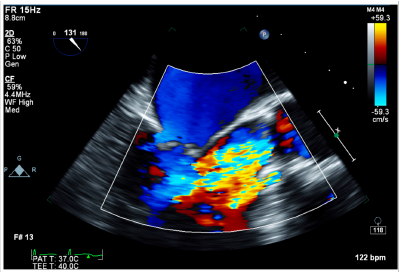
Figure 3. Transesophageal echocardiogram long axis view with color doppler demonstrating two turbulent jets, consistent with severe aortic